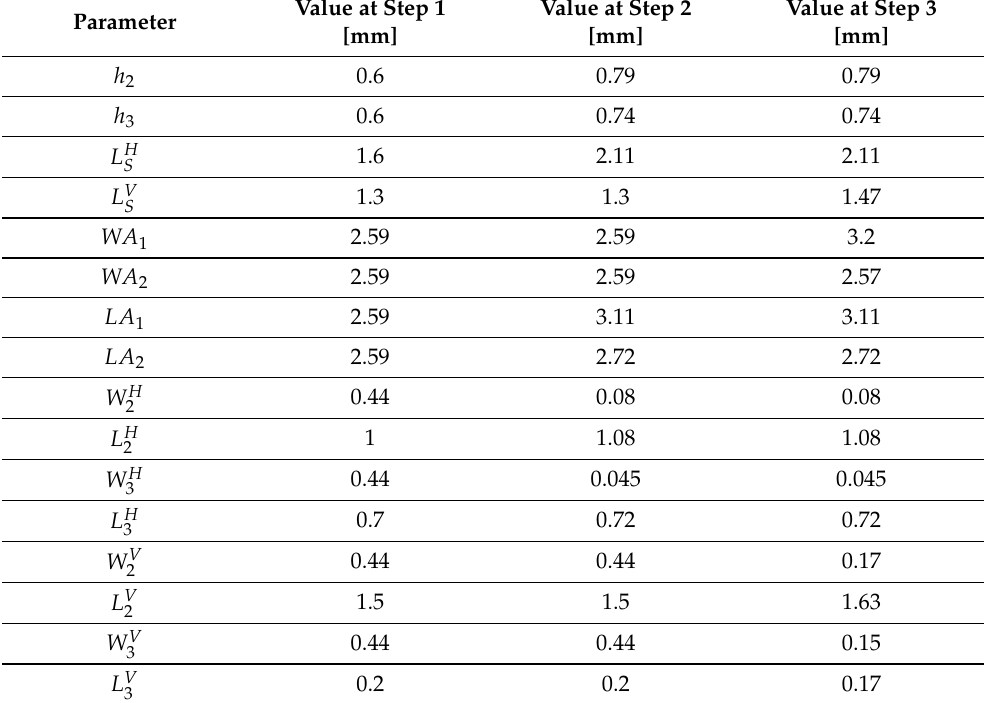
Table 2. The optimized